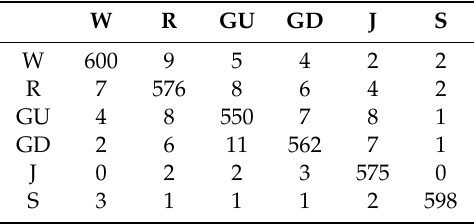
Table 6. Confusion matrix for DMGSOSEN-based HAR on the data from the waist when the initial pool size is 100.